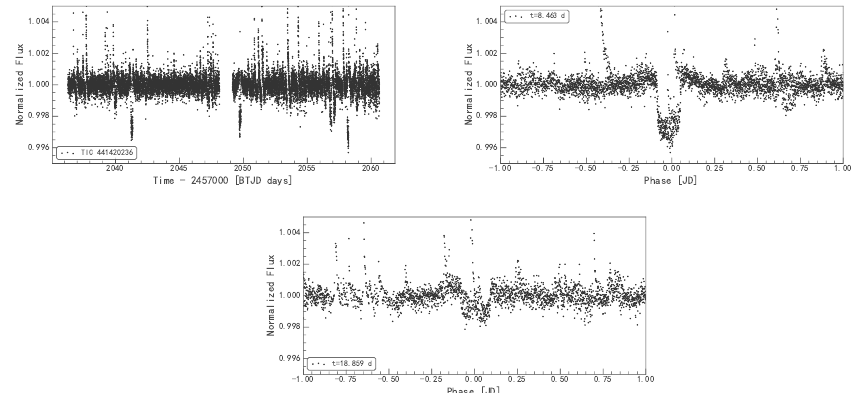
Figure 3. TESS light curve of AU Mic (Sector 27). ( Top left ): the detrended light curve. ( Top right and Bottom ): the phase-folded light curve to the period of 8.463 d and 18.859 d, respectively. DS Tuc A The star is a member of the Tucana-Horologium young moving group, which has a mass of ∼ 1 M (cid:12) and radius of ∼ 0.9 R (cid:12) . It was observed by TESS in Sectors 1, 27, and 28. The raw light curve shows a modulation with a semi-amplitude of ∼ 3% and period of ∼ 2.9 day. The detrended and phase-folded light curves are shown in Figure 4. Newton et al. [68] reported the detection of DS TUC Ab in this system, which is a planet with size larger than Neptune but smaller than Saturn and a period of 8.14 day. From the TESS light curve, the star is in a relatively active phase during the TESS observation, which makes it relatively harder to search for smaller planets.